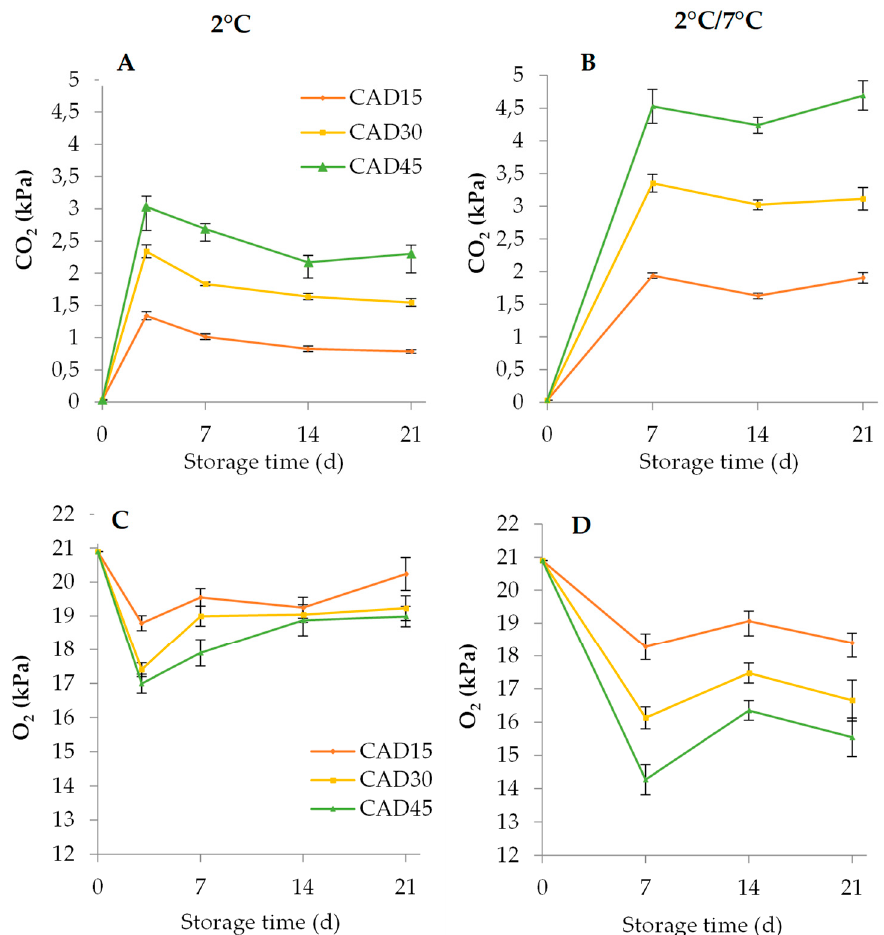
Figure 2. Evolution of internal atmosphere composition (O 2 and CO 2 ) of broccoli florets packaged in films with different level of micro-perforation (CAD15, CAD30 and CAD45) throughout storage at 2 °C ( A , C ) and 2 °C/7 °C ( B , D ). Vertical bars represent standard error (n = 5, n is the number of samples analyzed).